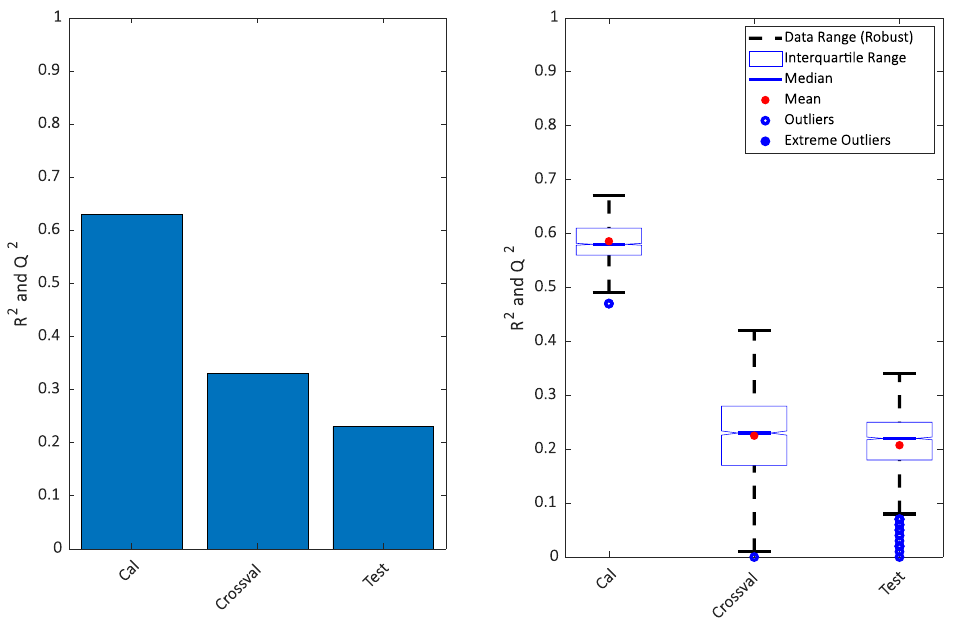
Figure 5. Variance described for the model plotted in Figure 4 (left) and repeated 500 times (right).